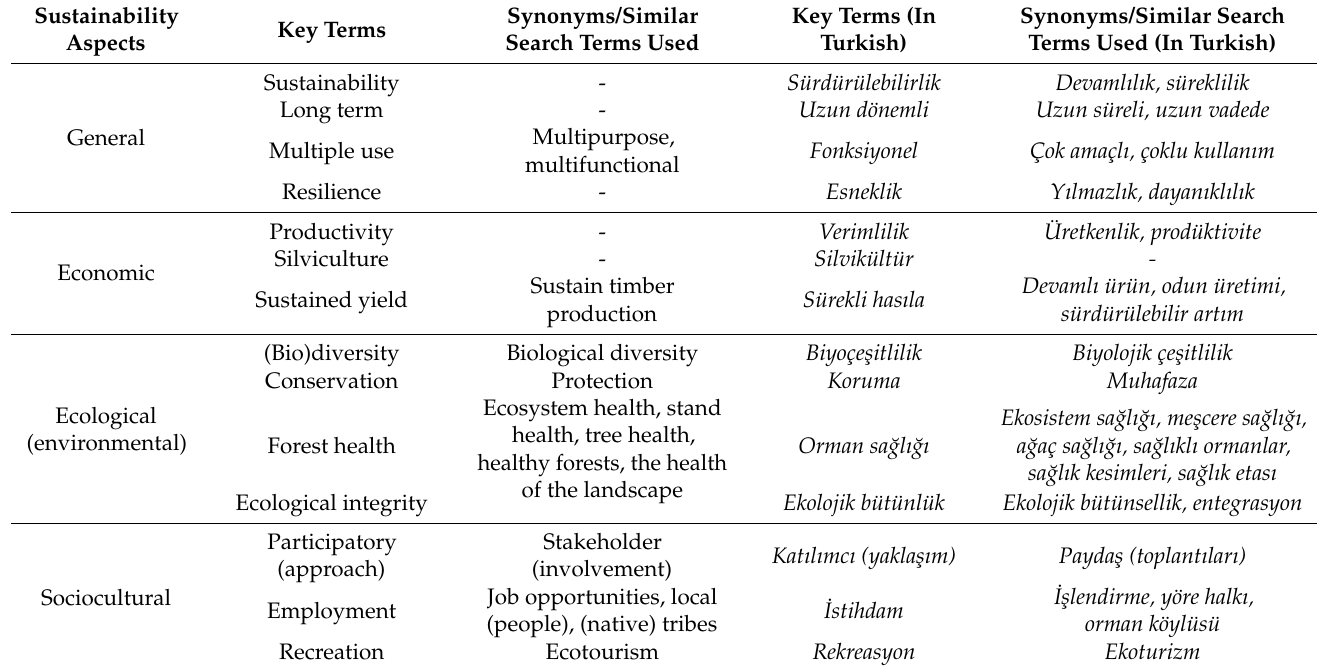
Table 2. The key terms and their synonyms used to characterize economic, ecological, and sociocul- tural aspects of forest sustainability in both languages (revised from